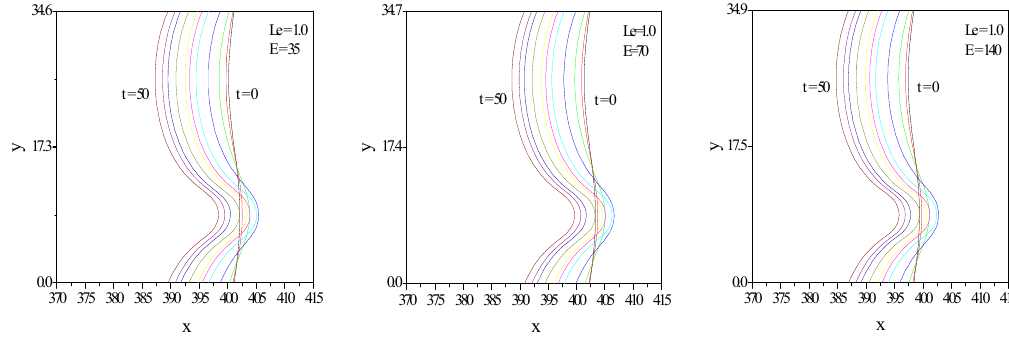
Fig. 5. The evolution of cellular fronts at Le = 1.0 and E = 35, 70 and 140 in adiabatic flames ( t = 0, 5, 10, . . . , 50).